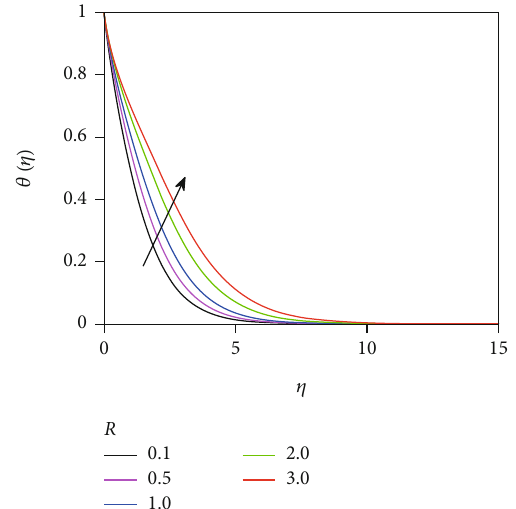
Figure 6: Signi fi cance of the radiation parameter on temperature plot.